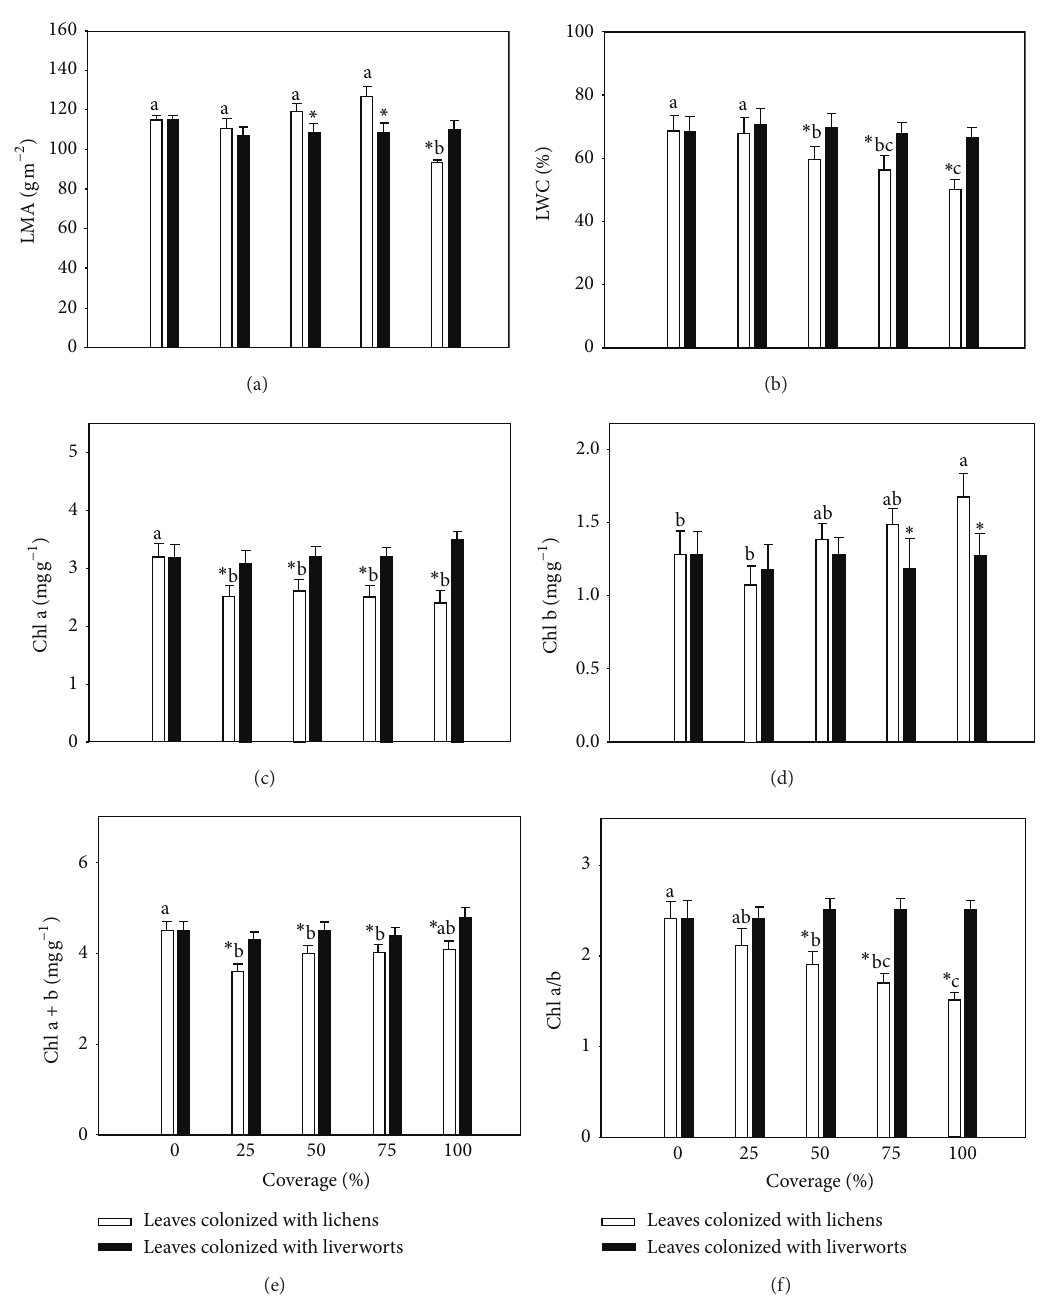
Figure 1: Physical leaf traits of Photinia prunifolia colonized with lichens and liverworts at different coverages (0%, 25%, 50%, 75%, and 100%). (a) Leaf mass per area (LMA) (gm −2 ), (b) leaf water content (LWC) (%), (c) concentration of chlorophyll a (Chl a) (mgg −1 ), (d) concentration of chlorophyll b (Chl b) (mgg −1 ), (e) concentration of chlorophyll a + b (Chl a + b) (mgg −1 ), and (f) chlorophyll a/b ratio (Chl a/b) (mean ± 1 SE) ( 𝑛 = 5 ). Different lowercase letters above the bars indicate the differences of physical leaf traits among leaves colonized with lichens; the symbol ∗ indicates the difference between leaves colonized with liverworts and lichens ( 𝑃 < 0.05 ).